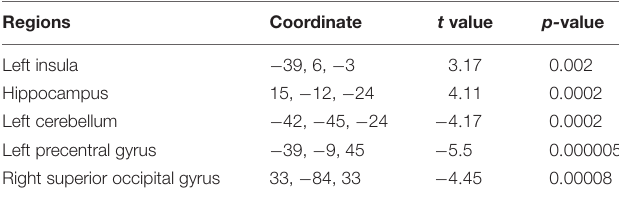
TABLE 3 | Comparison of fALFF measurements in patients with KOA and control